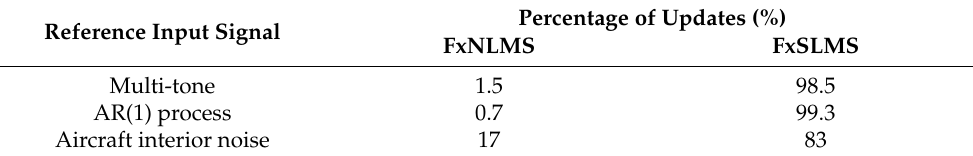
Figure 13. Power spectrum of the error signal at observation microphone by taking into account an aircraft interior noise as a reference signal. Table 3. Updating percentage by processing three reference